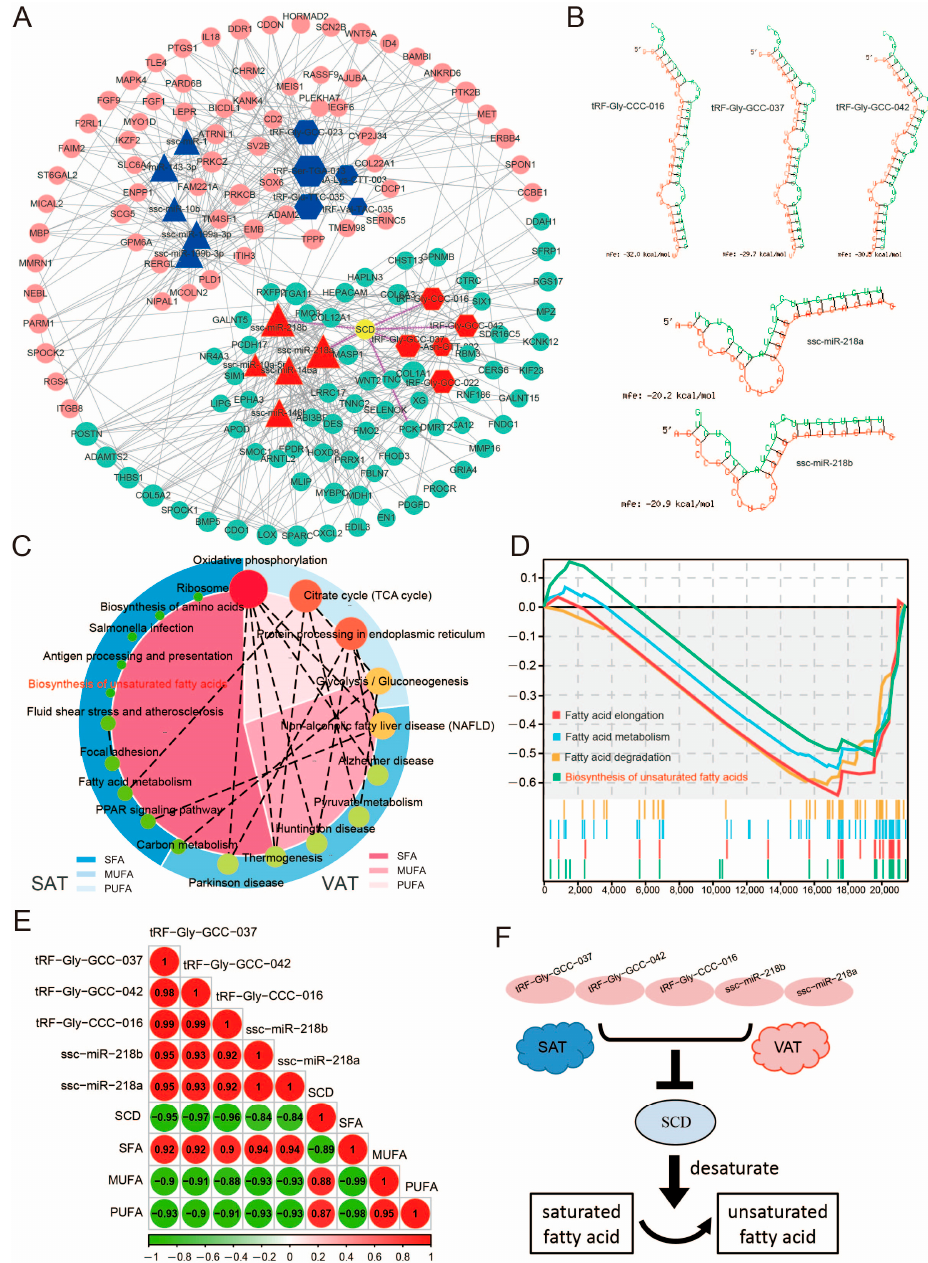
Figure 7. Unsaturated fatty acid metabolism in both the SAT and the VAT. ( A ) Node diagram of the tsRNA/miRNA/mRNA co-expression network. ( B ) Secondary structures of tRF-Gly-GCC-037, tRF-Gly-GCC-042, tRF-Gly-CCC-016, miR-218a, and miR-281b with potential binding sites of the SCD gene (N = 3). ( C , D ) Gene set enrichment analysis (GSEA) for SAT and VAT. Fatty acid-related signaling pathways are shown. ( E ) Correlation analysis between genes and different fatty acids. ( F ) Schematic representation of the involvement of tRFs and miRNAs in the control of fatty acid composition in adipose tissue.